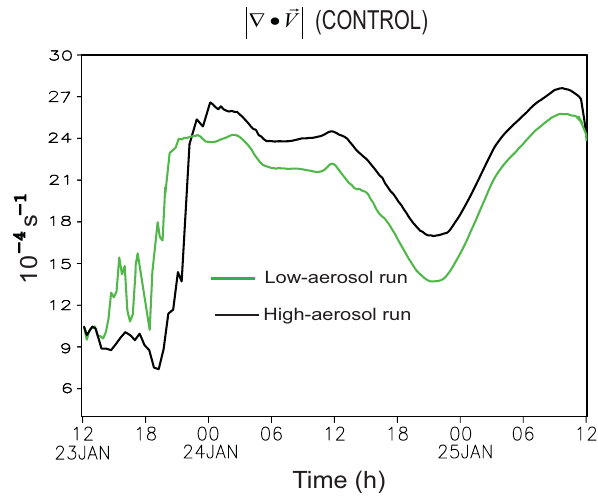
Fig. 7. Time series of averaged | ∇ • V | over horizontal domain at the lowest 1km for the high- and low-aerosol runs in